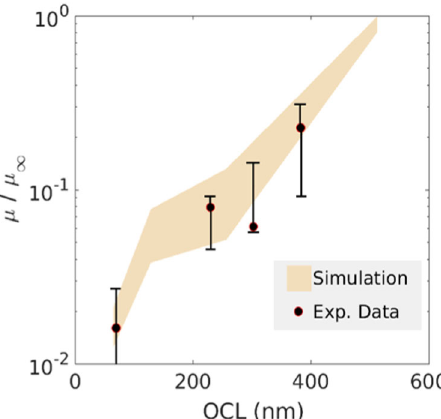
Fig. 3 A simulation of the relationship between mobility and orientational correlation length (OCL) of domains in a semicrys- talline polymer when there is no substantial amorphous region between crystallites. The experimental data (with error bars) for the carrier mobility is for PBTTT from literature 12 . The carrier mobility is normalized with respect to the value at the maximum OCL — 512